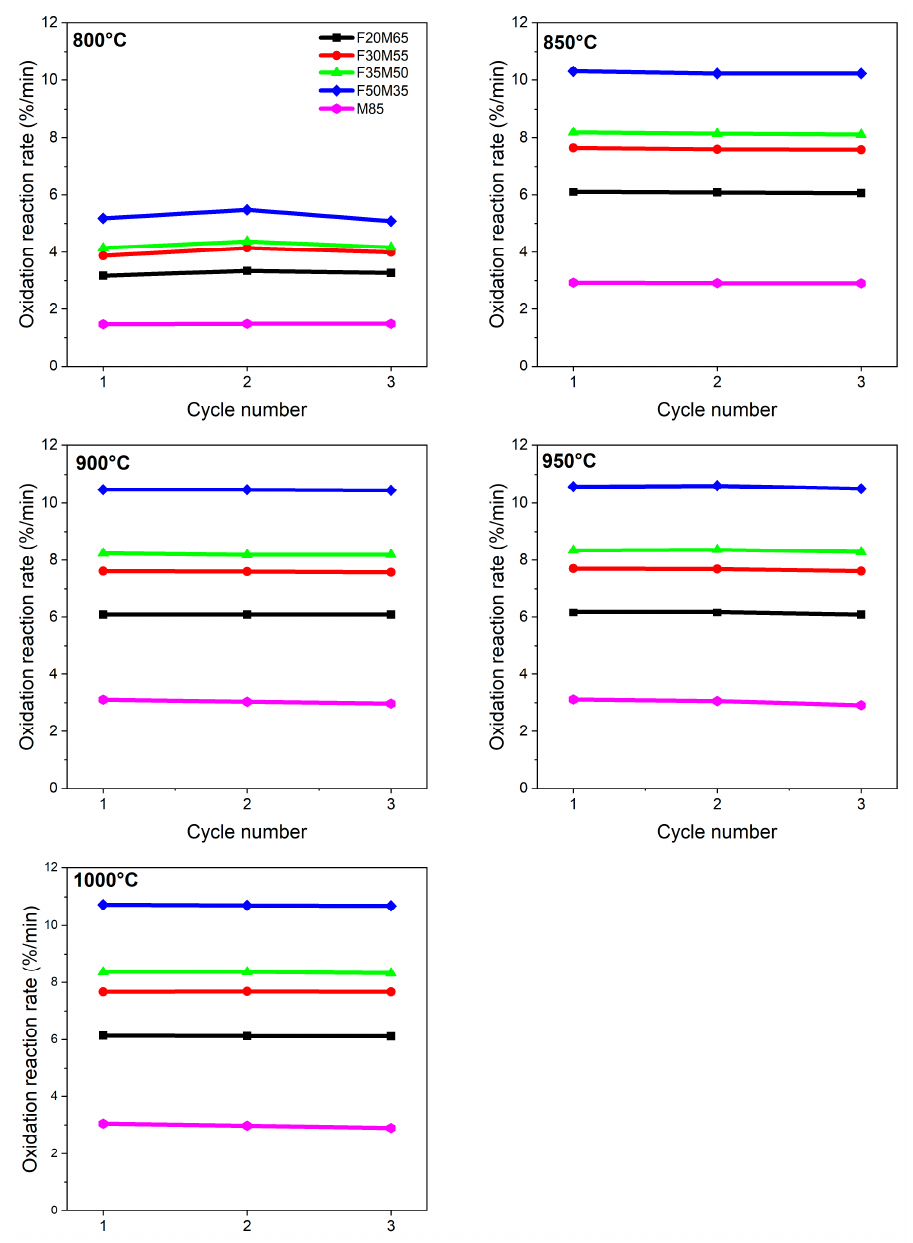
Figure 6. Oxidation reaction rates for OCs versus cycle number at given temperatures (800, 850, 900, 950, 1000 °C).